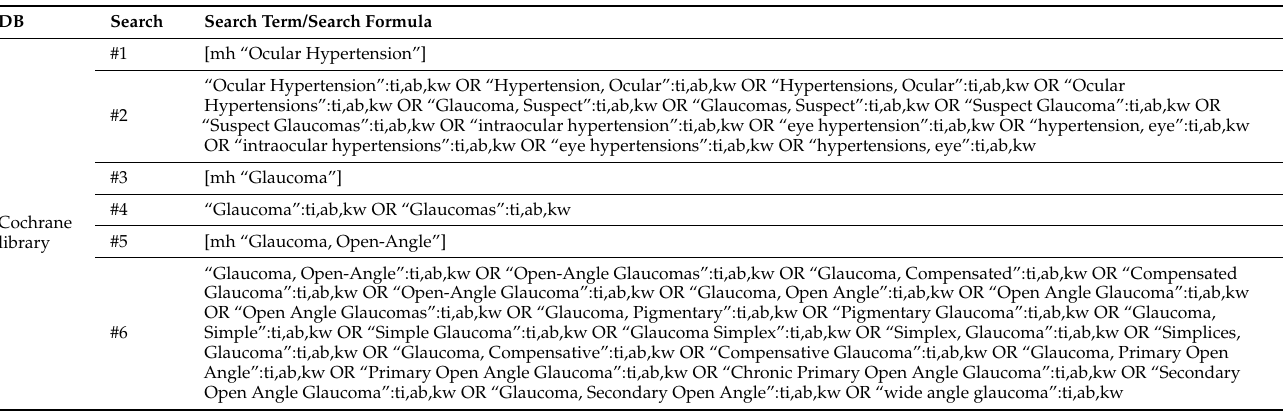
Table A3. Search terms and formula for Cochrane